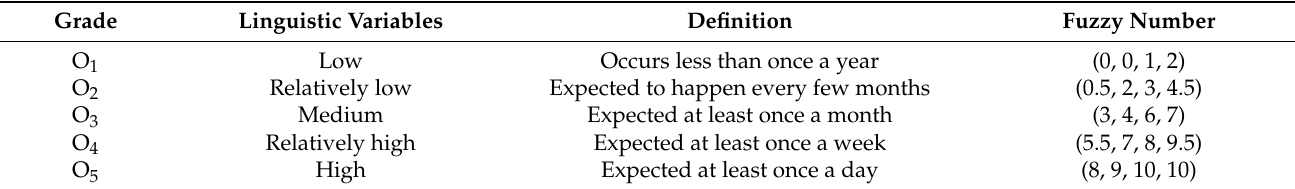
Table 3. Probability of risk O fuzzy rating.